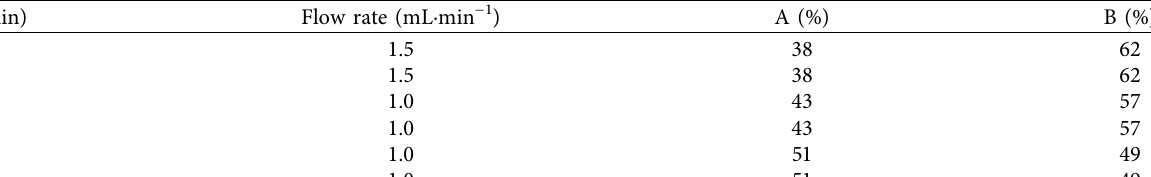
Table 1: Gradient elution conditions.